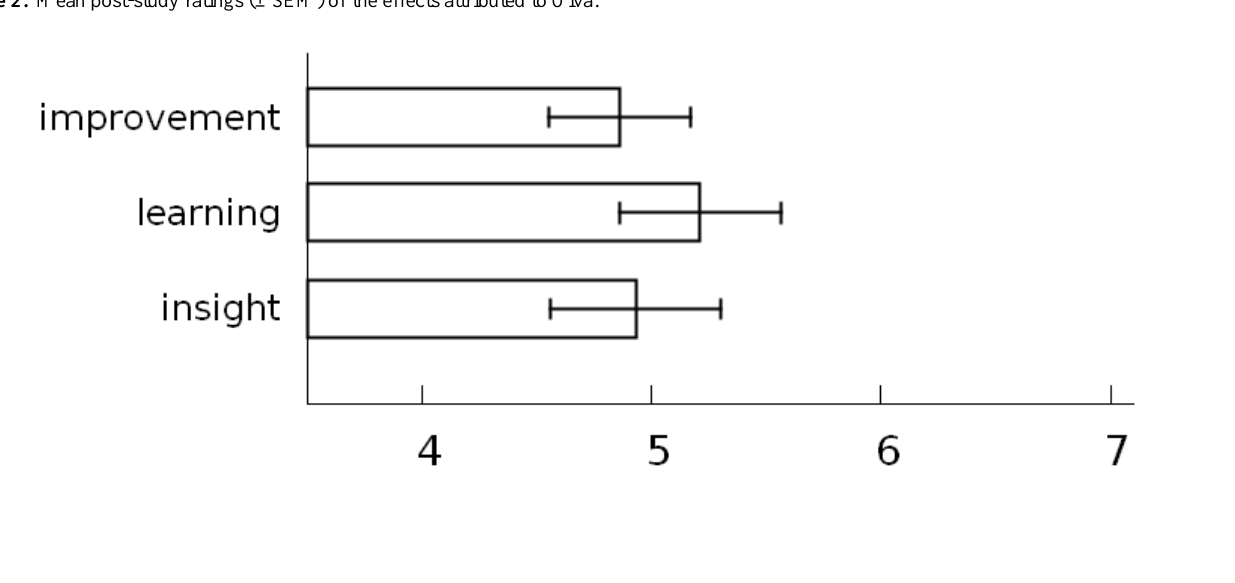
Figure 2. Mean post-study ratings (± SEM) of the effects attributed to